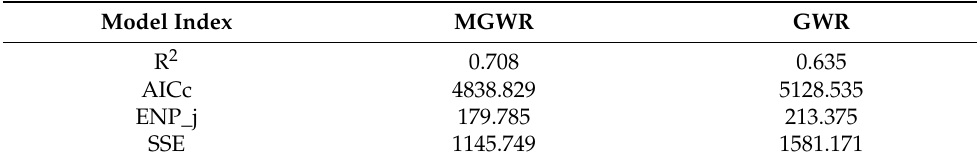
Table 11. Comparison of the model indexes of MGWR model and